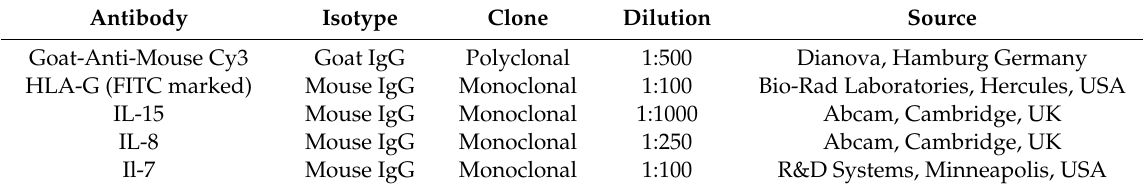
Table 4. This table shows the antibodies used for immunohistochemical characterization in this study. Antibody Isotype Clone Dilution Source Goat-Anti-Mouse Cy3 Goat IgG Polyclonal 1:500 Dianova, Hamburg Germany HLA-G (FITC marked) Mouse IgG Monoclonal 1:100 Bio-Rad Laboratories, Hercules, USA IL-15 Mouse IgG Monoclonal 1:1000 Abcam, Cambridge, UK IL-8 Mouse IgG Monoclonal 1:250 Abcam, Cambridge, UK Il-7 Mouse IgG Monoclonal 1:100 R&D Systems, Minneapolis,